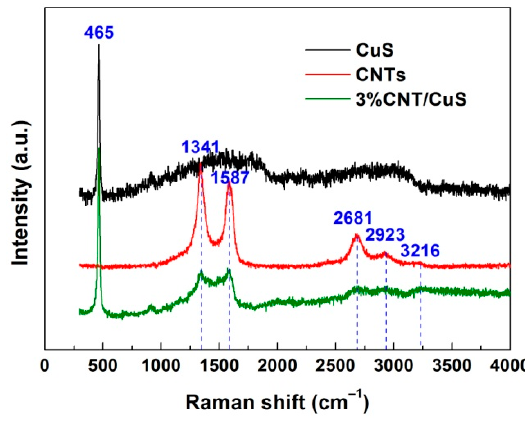
Figure 9. Raman spectra of CuS (12 h-20 °C), CNTs, and 3% CNT/CuS.